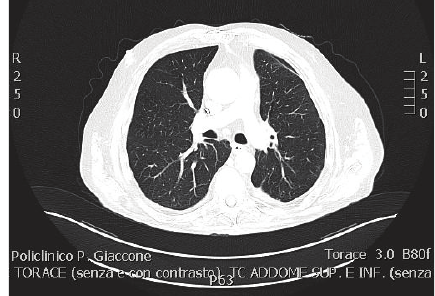
Figure 3: Normal followup CT